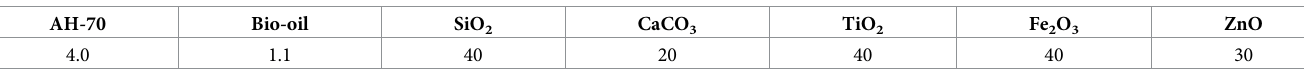
Table 10. “¥” refers to Chinese Yuan (CNY). Table 9. Unit prices (¥/kg) of different